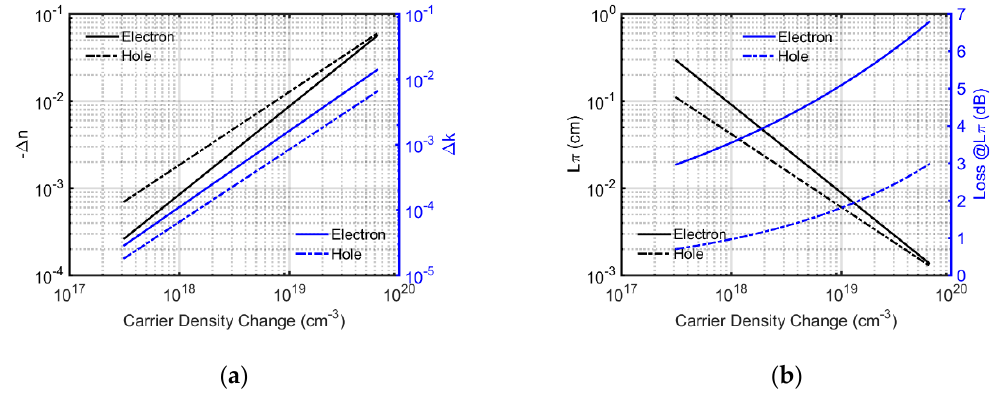
Figure 7. ( a ) Calculated refractive index change and extinction ratio change in Si as a function of free electron or hole density, respectively; ( b ) Calculated π -shift length and free carrier absorption loss at such length in Si as a function of free electron or hole density, respectively. The calculation is based on formula and coefficients found in Ref. [81].